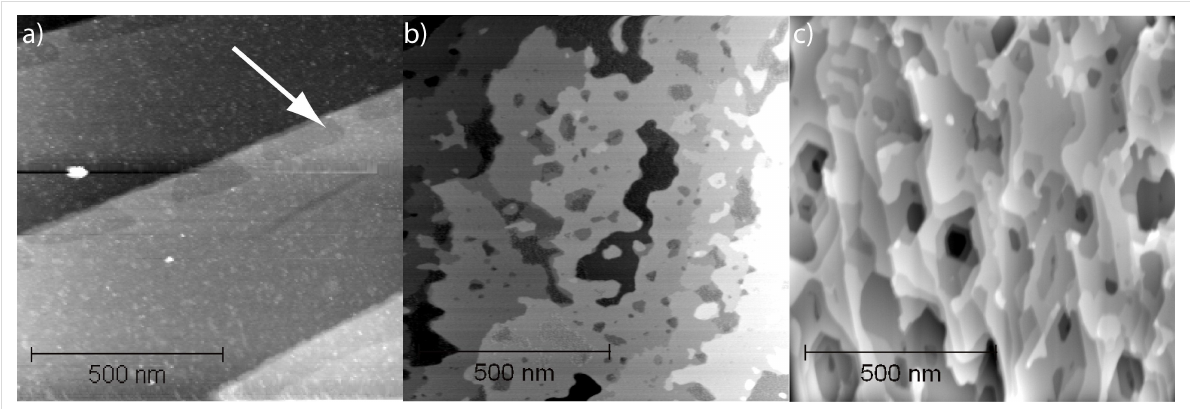
Figure 1: Topography images of the SiC(0001) sample (a) before annealing, (b) after oxide removal at 1000 °C, and (c) after graphene growth at 1300 °C. Step heights in (a) are 1.5 nm between the large terraces and 0.25 nm towards the small depressed islands (indicated by the arrow). Step heights in (b) are 0.25, 0.50 and 0.75 nm, evenly distributed. Step heights in (c) vary from 0.09 nm to 0.75 nm.